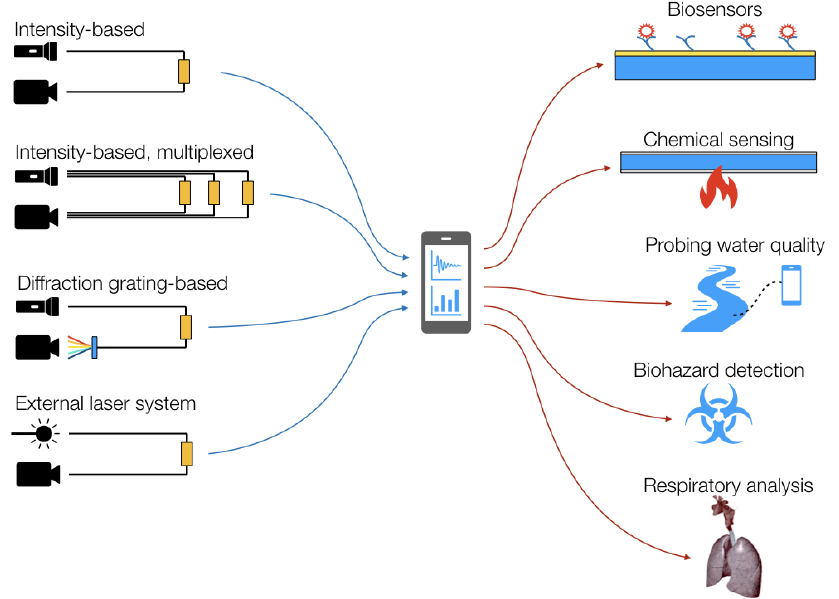
Figure 11. Illustration of the main architectures ( left ) and applications ( right ) of optical fiber biosensors based on smartphones.